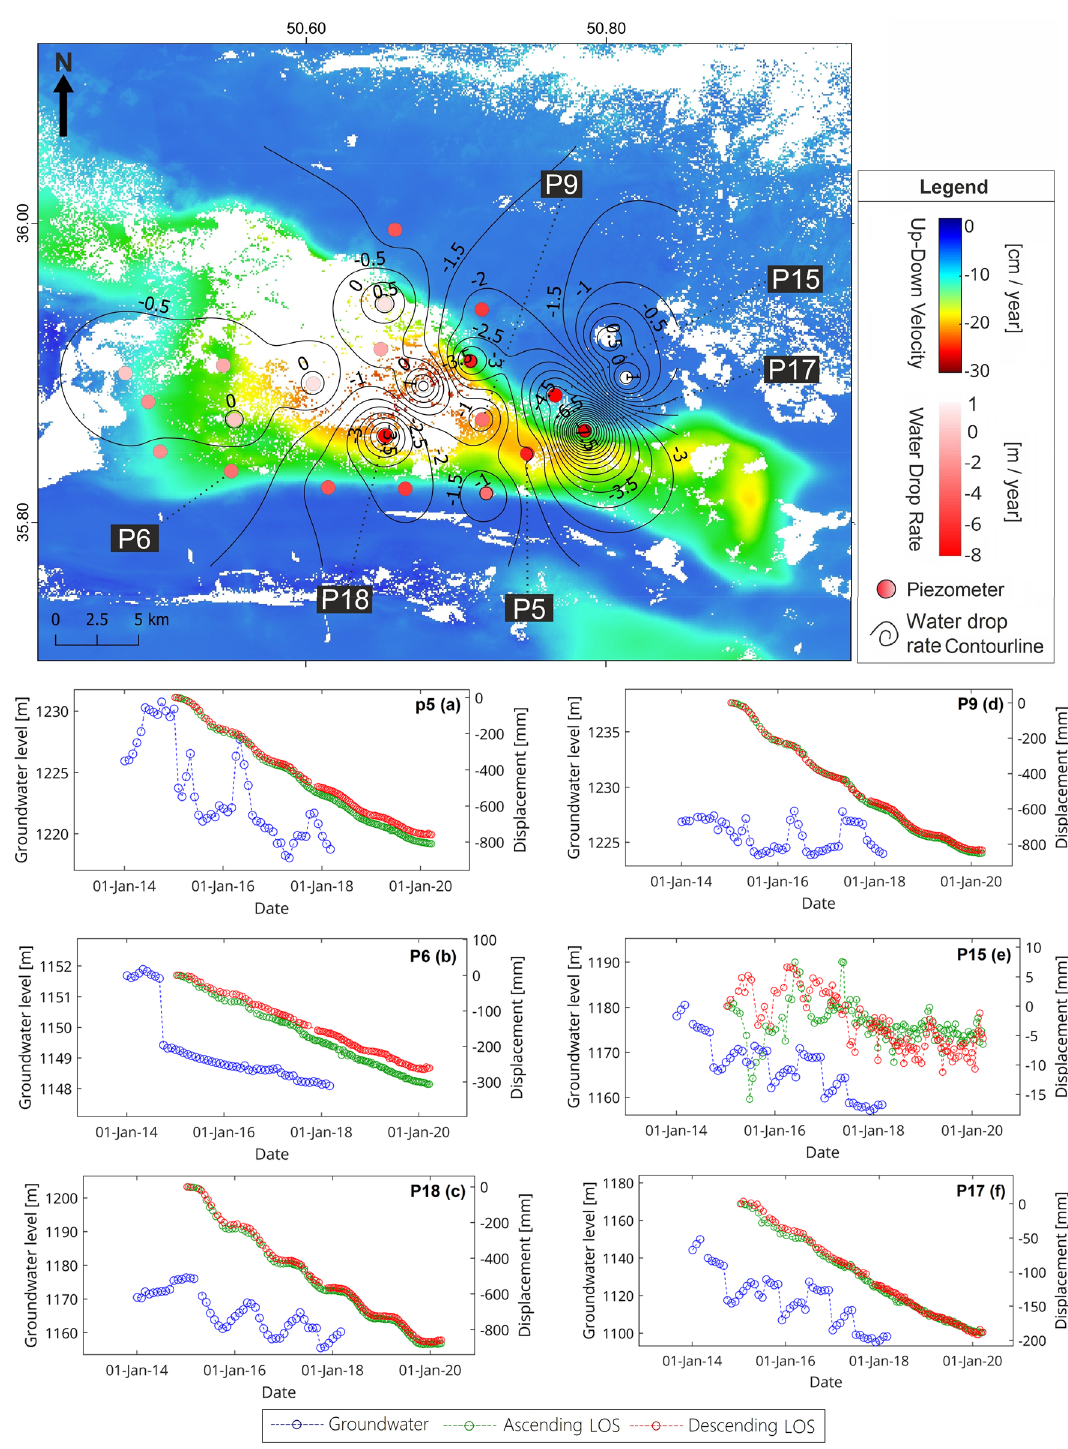
Figure 8. Position and vertical velocity map of piezometer water level variations, comparison of time series of water level of piezometers (blue), and InSAR time series of ascending (green) and descending (red) tracks for piezometers ( a ) P5, ( b ) P6, ( c ) P18, ( d ) P9, ( e ) P17, and ( f ) P15. This figure was created using the QGIS version Desktop 3.18.1 software (https:// qgis. org/ en/